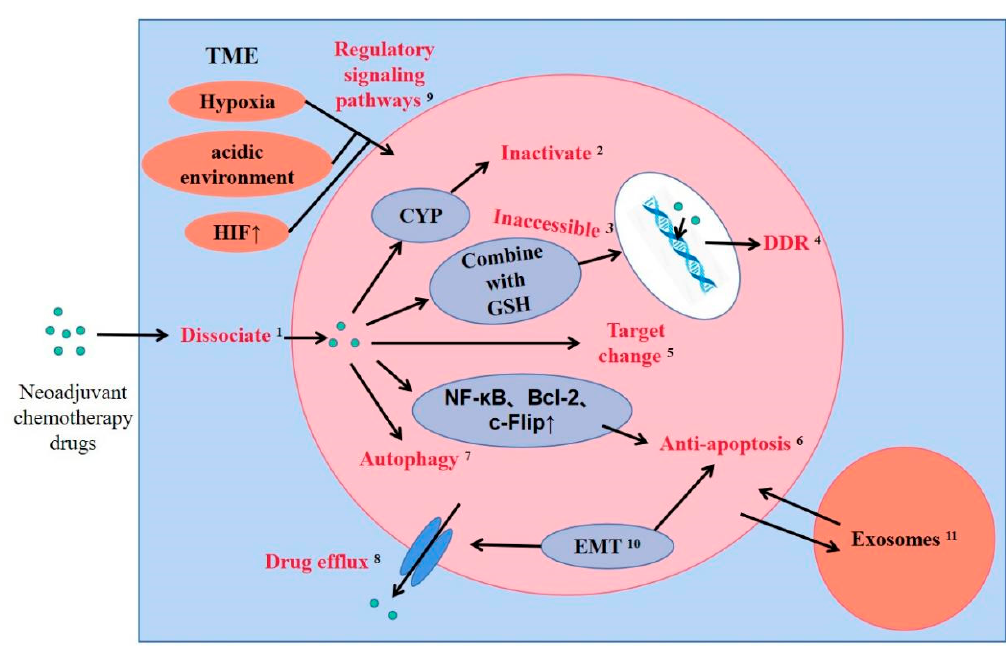
Figure 2. Drug resistance mechanism of neoadjuvant chemotherapy in breast cancer. 1 Weakly basic drugs dissociate in acidic TME. 2 CYP can inactivate drugs. 3 Platinum cannot enter the nucleus to play a role after being combined with GSH. 4 Drugs that directly or indirectly damage DNA can induce breast cancer cells to produce DDR. 5 Trastuzumab can induce nuclear HER4 up-regulation and nuclear HER2 translocation. 6 Over-expression of NF- κ B, Bcl-2 and c-Flip can inhibit cell apoptosis. 7 Endoplasmic reticulum stress or DNA damage can induce autophagy. 8 The ABC transporter family mediates drug efflux, mainly P-gp, MRP and BCRP. 9 TME can induce drug resistance through a variety of signaling pathways. 10 The overexpression of N-Cadherin and Vimentin in EMT can inhibit cell apoptosis and promote drug efflux. 11 Exosomes can transmit miRNA and protein between cells to produce drug resistance.